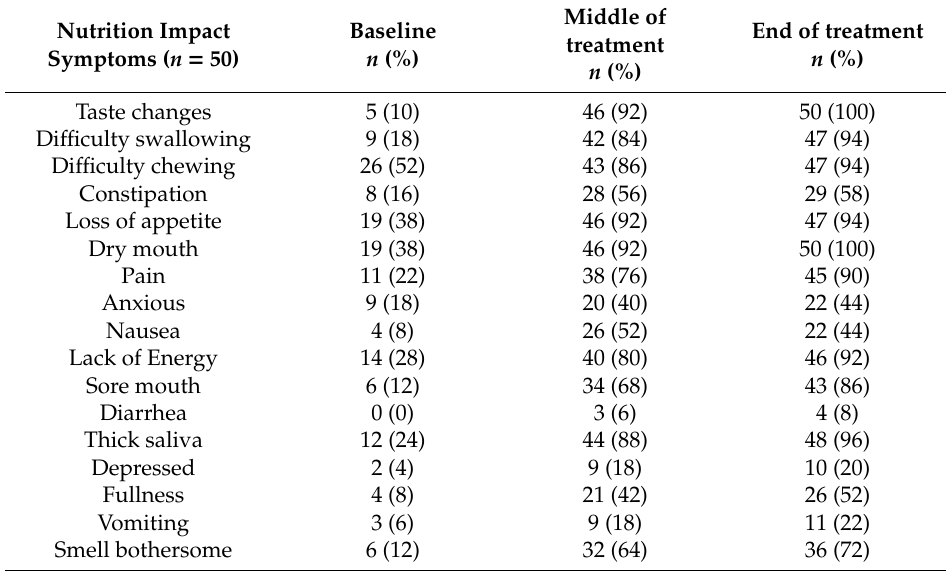
Table 4. Prevalence of NIS from the HNSC © in participants with severity scores ≥ 2 for orally fed head and neck cancer patients over